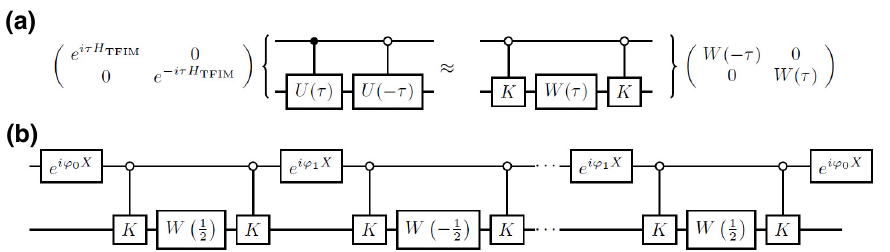
FIG. 5. The simplified quantum circuit for simulating the TFIM Hamiltonian using QETU. (a) The controlled time evolution of the TFIM Hamiltonian without directly controlling the Hamiltonian. (b) The simplified circuit for implementing QETU. The evolution (cid:9) (cid:8) − 1 can also be implemented as W operator W 2